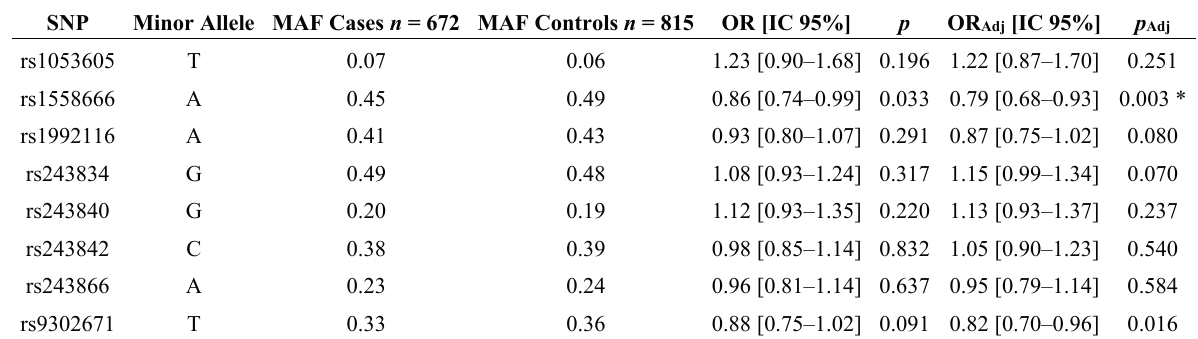
Table 2. Association of MMP2 common tagSNPs with mitral valve